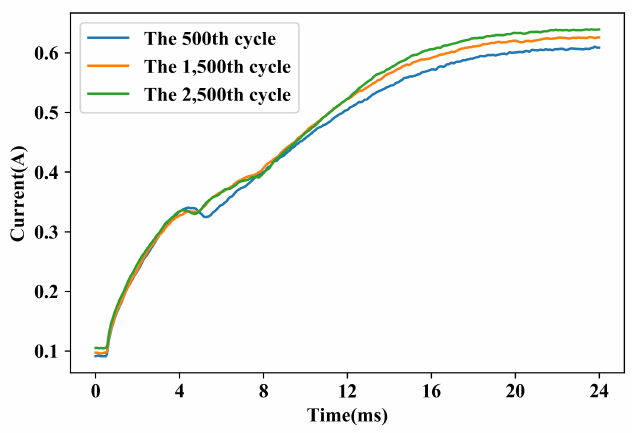
Figure 5. Driven current curves of the high-speed solenoid valve at different life